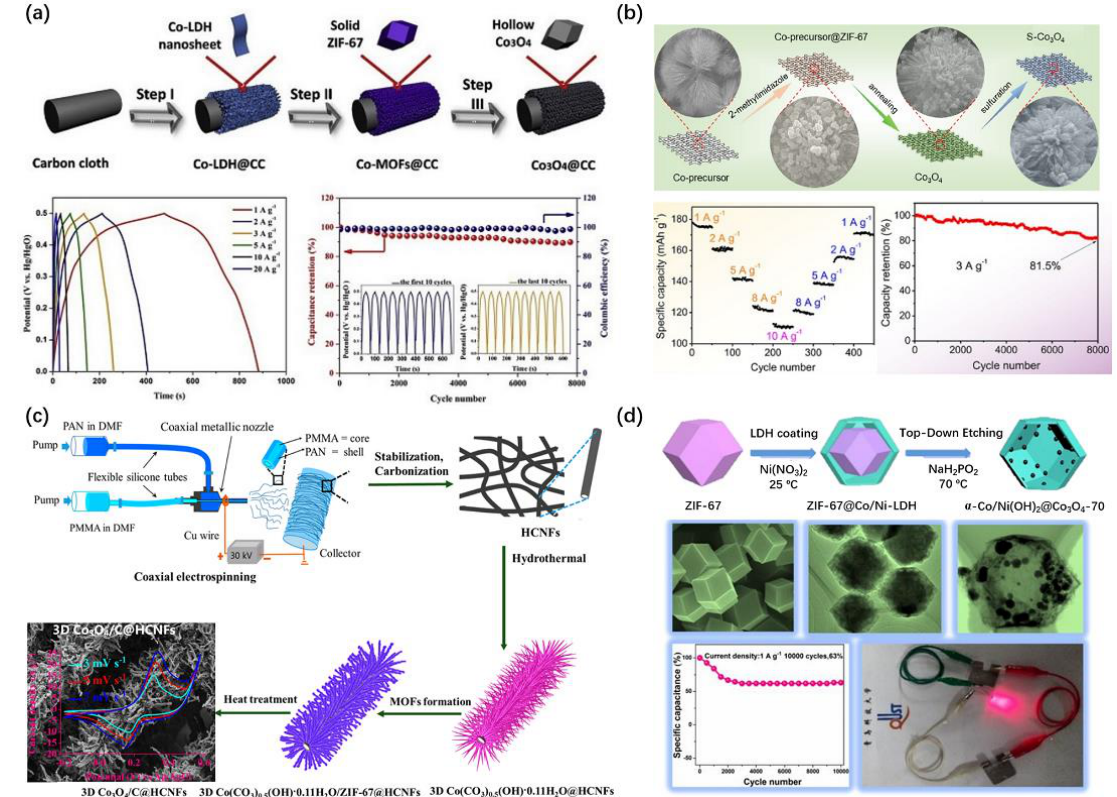
Figure 5. Schematic illustration for the preparation and electrochemical properties of ( a ) hollow Co 3 O 4 arrays on carbon cloth: Step I, electrochemical deposition; Step II, in situ growth; and Step III, two steps annealing [92]. ( b ) S-Co 3 O 4 electrode [93], ( c ) 3D Co 3 O 4 /C@HCNFs nanocomposite [94] and ( d ) α-CoNi(OH) 2 @Co 3 O 4 -70 nanocage [95]. ( a , b , d ) Elsevier, 2020. ( c ) American Chemistry Society, 2020.